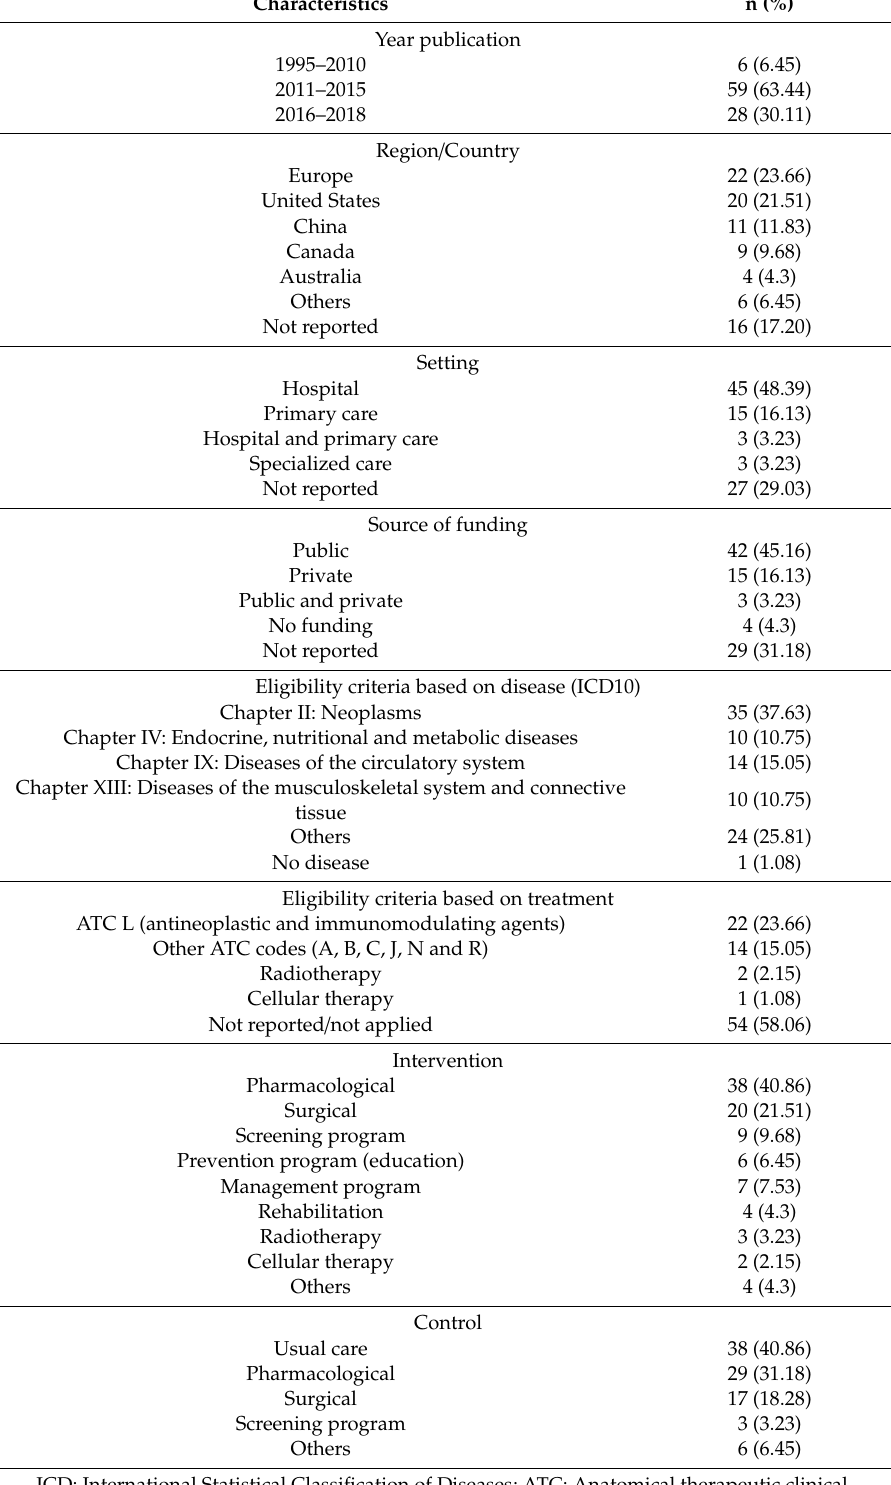
Table 1. Characteristics of studies